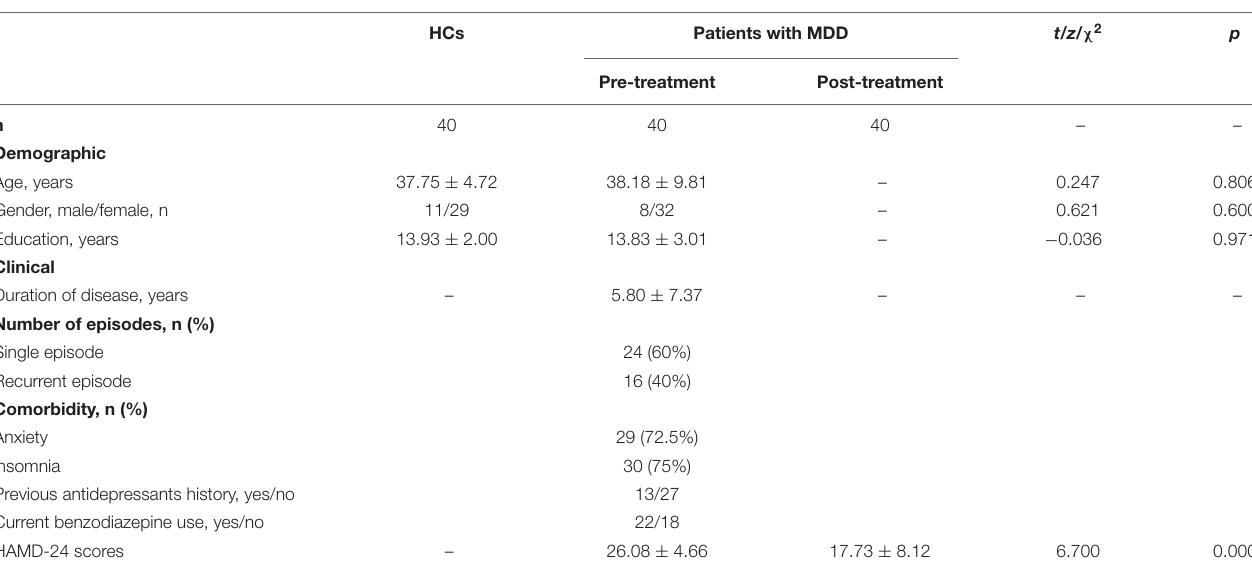
TABLE 1 | Demographic and clinical characteristics of participants. HCs Patients with MDD t/z/ χ 2 p Pre-treatment